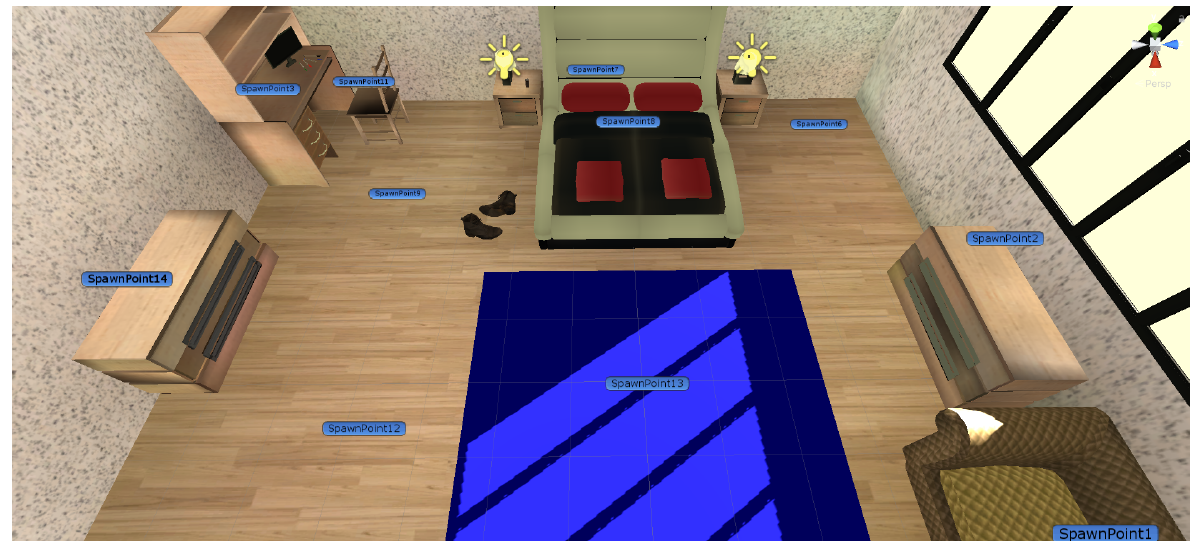
Figure 2. The spawn